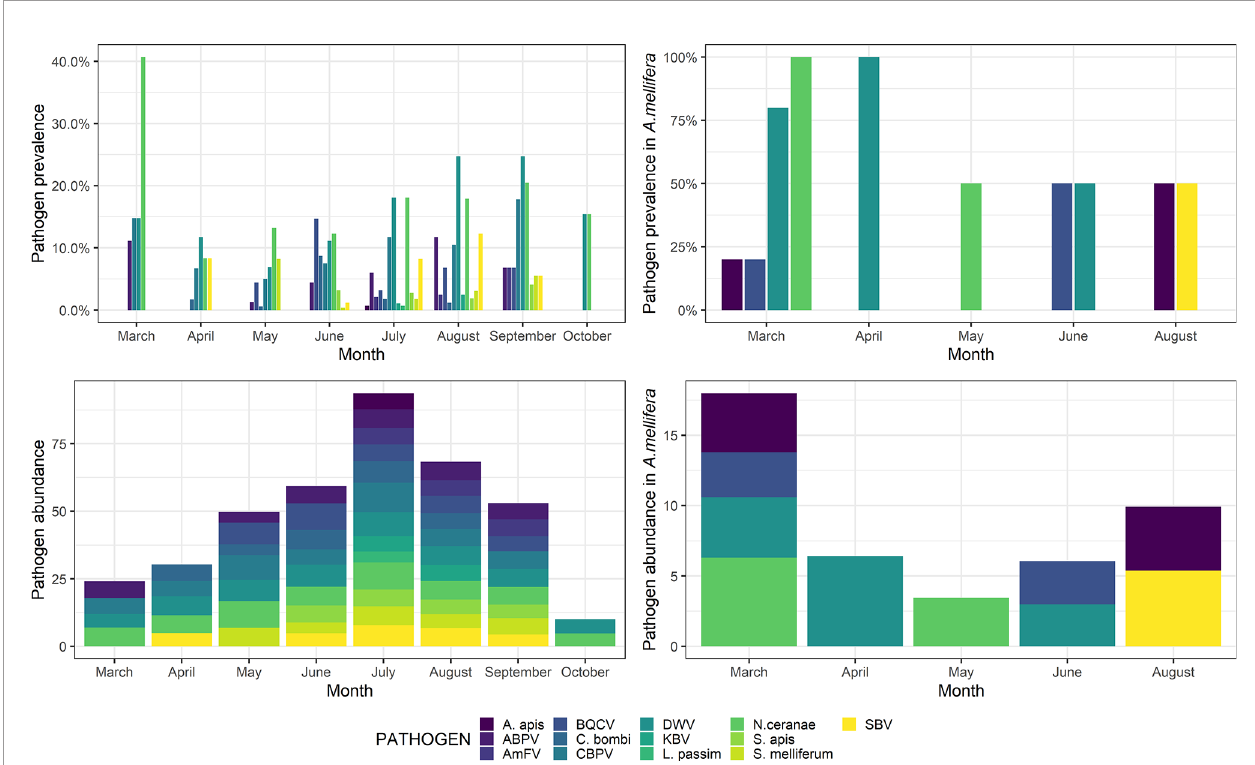
FIGURE 3 | Pathogen prevalence (top) and abundance (bottom) throughout the sampling season (March – October) in wild species (left) and Apis mellifera (right). Abundance is shown as a decimal